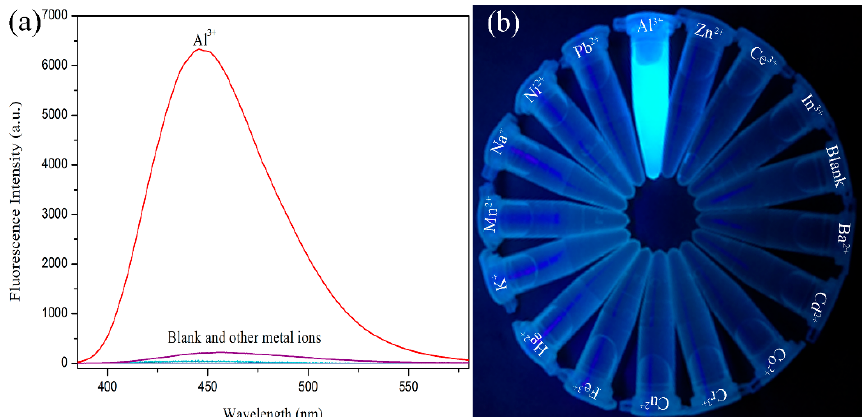
Figure 1. ( a ) Fluorescence spectra of PEGBAB (10 μ M) in the presence of various metal ions (2 equiv.) in aqueous solution. ( b ) The photograph of PEGBAB with various metal ions (2 equiv.) in aqueous solution under a 365 nm UV lamp.